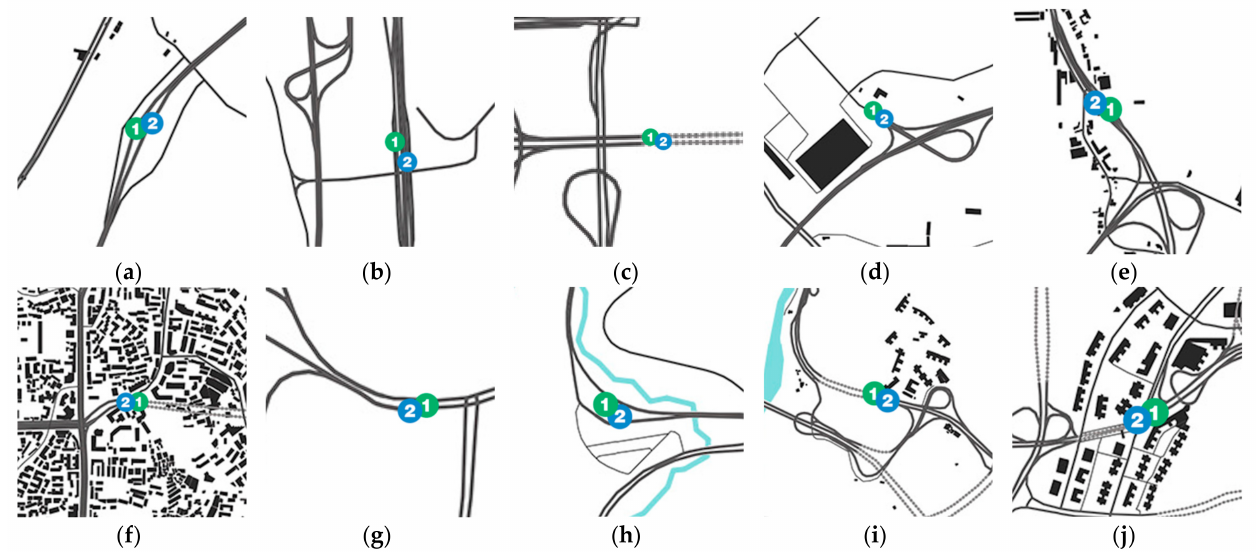
Figure 1. Visualization map of comparison between the longitude and latitude data determined by the algorithm and provided by the government. ( a ) Checkpoint of Guiyang North Toll Station Bayonet. ( b ) Checkpoint of Zazuo Toll Station of Guiyang-Bixi Expressway. ( c ) Entrance of Daguan Tunnel on Qianlingshan Road. ( d ) Checkpoint of Shibanshao Toll Station Bayonet. ( e ) Checkpoint of Mengguan Toll Station Bayonet. ( f ) Yuan Tunnel Entrance of Beijing East Road. ( g ) Checkpoint of Shangmai Toll Station Bayonet. ( h ) Guiyang East Exit Expressway Toll Station. ( i ) Entrance of Xiaoguan Tunnel on Central Ring North Line. ( j ) Military Area South Factory Road Longmen